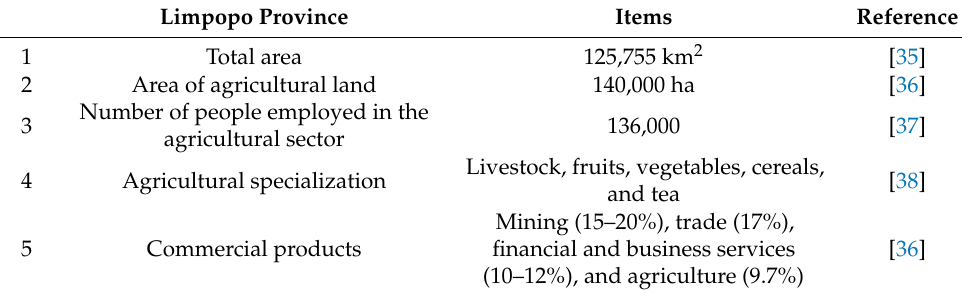
Table 2. Description of economic distributions in Limpopo Province.